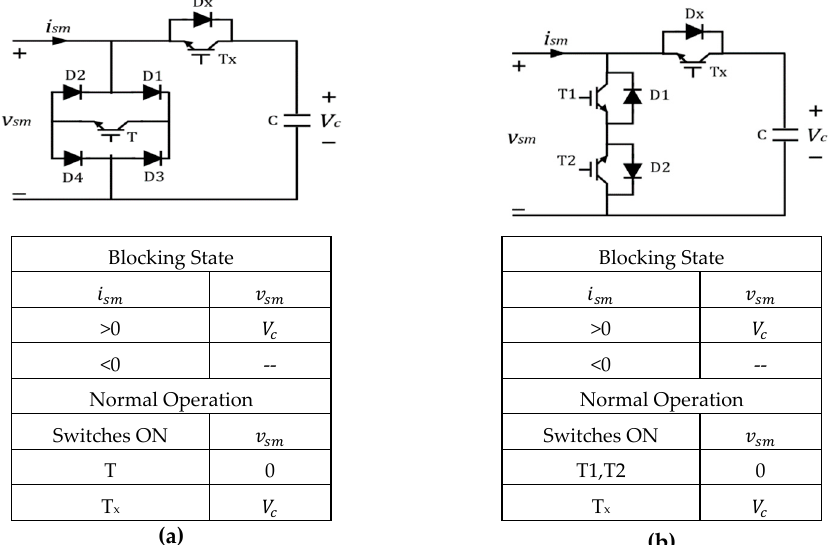
Figure 8. HBSM with modified bypass switch: ( a ) Type I; ( b ) Type II.